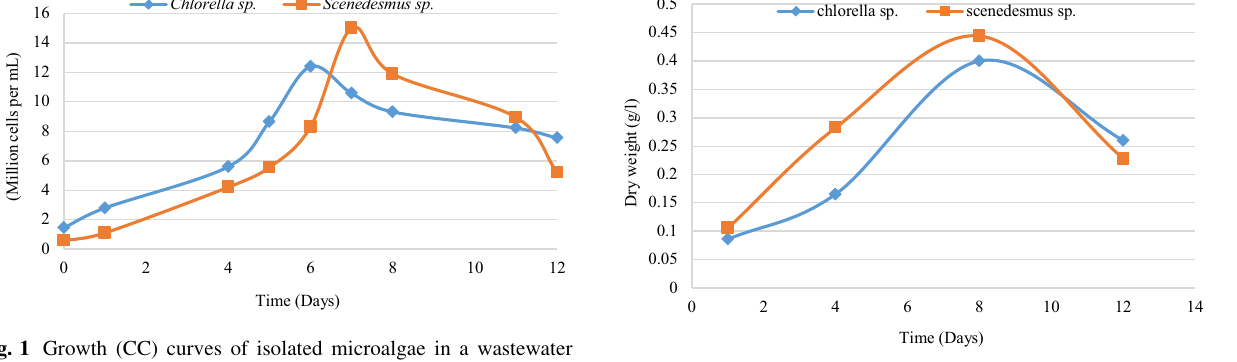
Fig. 3 Dry weight of isolated microalgae in a wastewater sample